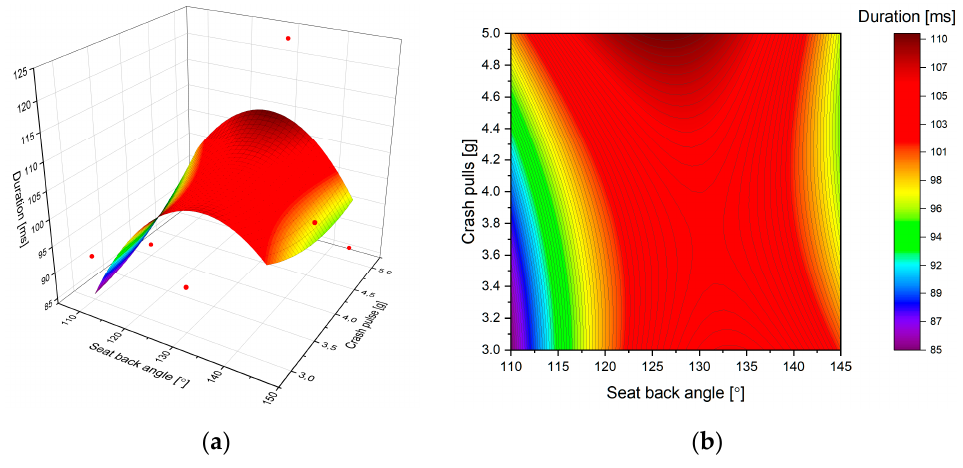
Figure 7. Predicted (estimated) response for the duration of acceleration: ( a ) fitted response surface; ( b ) fitted response profile.